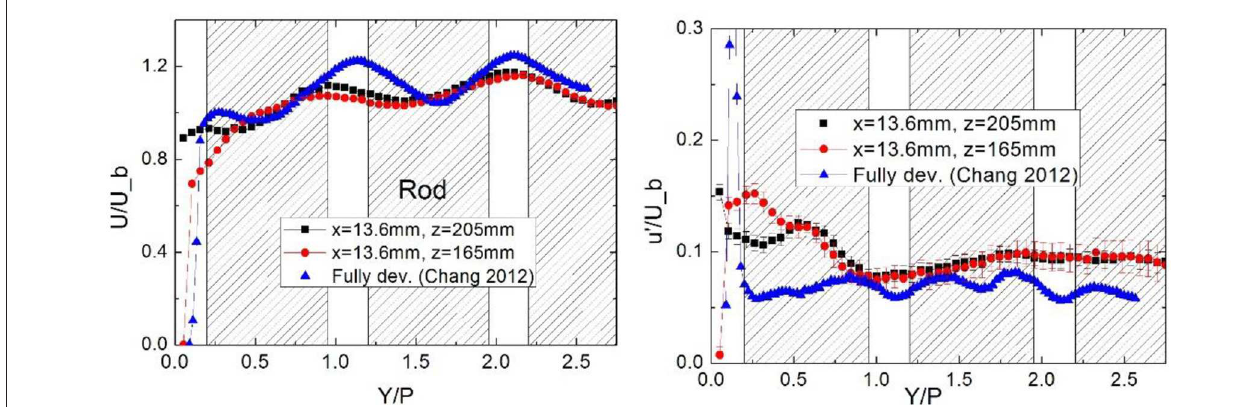
FIGURE 6 | Evolution of axial mean velocity distribution downstream of the mixing-vane spacer grid ( Re (C) Z =